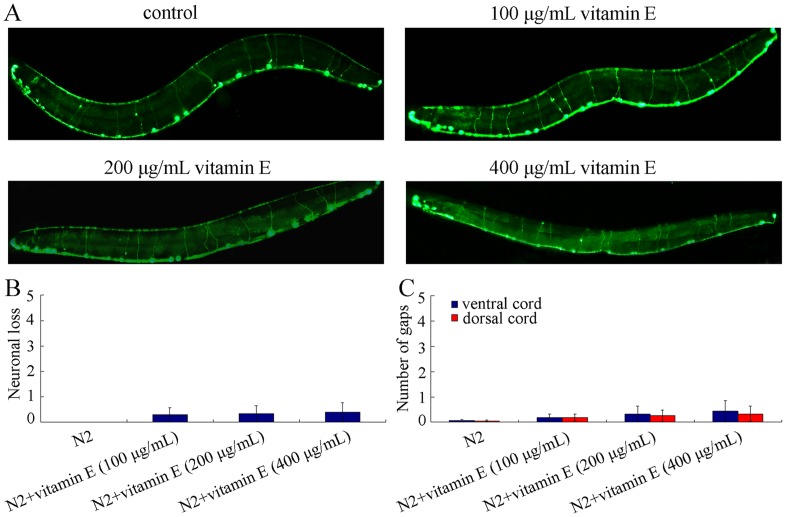
Effects of vitamin E treatment at different concentrations on development of GABAergic motor neurons in C. elegans.(A) Effects of vitamin E treatment on morphology of GABAergic motor neurons. The heads of nematodes were at the left of the images. (B) Effects of vitamin E treatment on neuronal loss of GABAergic motor neurons. (C) Effects of vitamin E treatment on dorsal/ventral cord gaps of GABAergic motor neurons. Data are expressed as mean ± SEM.